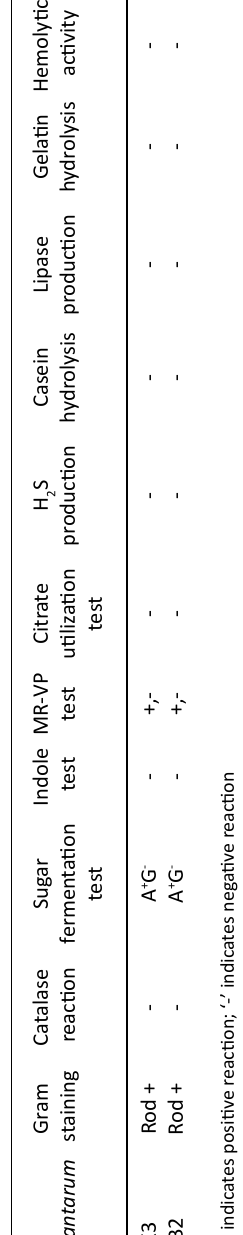
Fig. 4. Safety assessment of selected isolates L. plantarum SK-3 and L. plantarum DB-2 exhibited 75% and 62.5% sensitivity towards the antibiotics used in this work. L. plantarum SK-3 showed resistance towards Cefotaxime